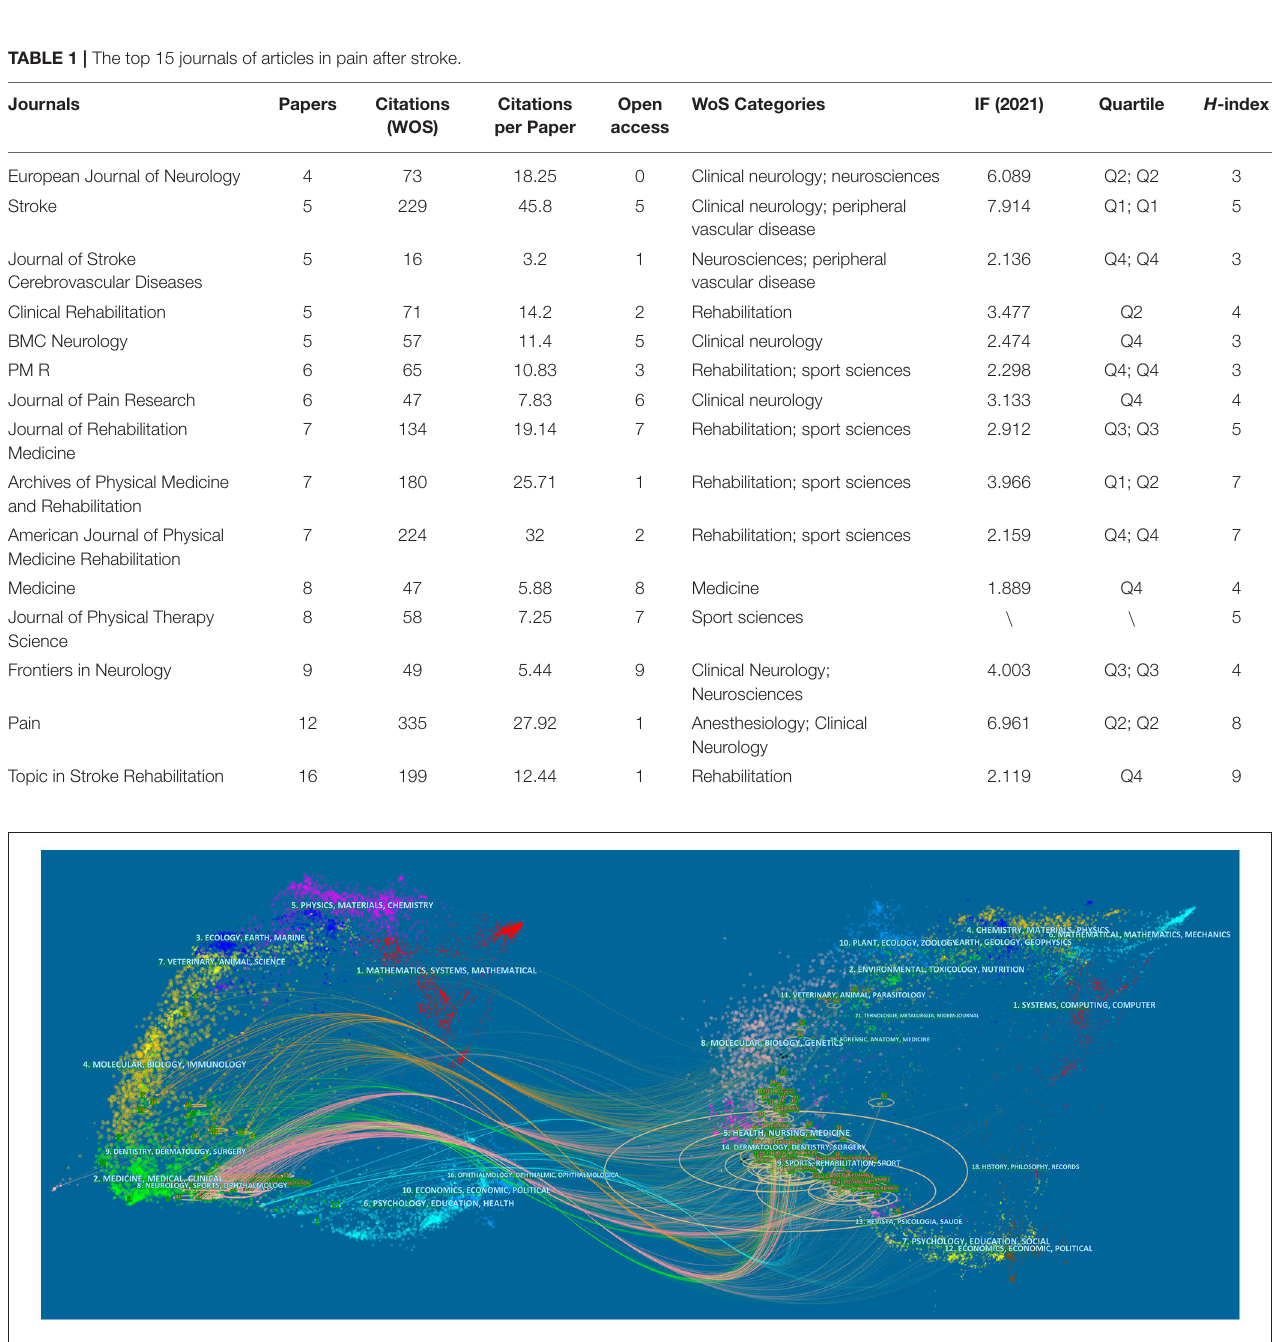
FIGURE 4 | Visualization of dual-map overlays of citing journals and cited journals of 322 studies published from 2010 to 2021. The colored curve indicates the path of citation, which originates from 11 fields of the citing journals on the left and points to 14 fields of the cited journals on the